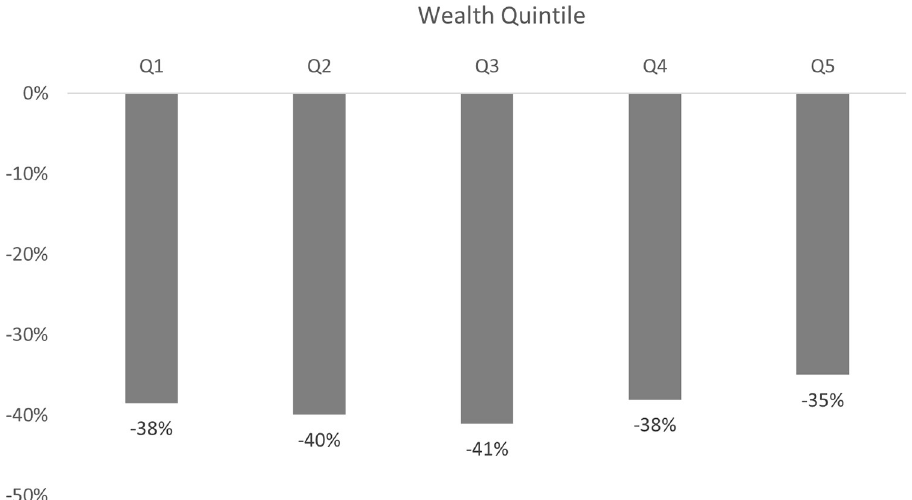
Fig 3. JKN households’ OOP payment reduction by wealth quintile, compared to uninsured HH. Note: � Statistically significant at 5%.